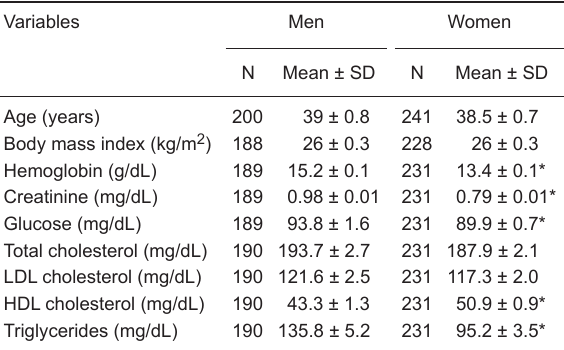
Table 2. Demographic, clinical and laboratory characteristics of the men and women of the study sample. Variables